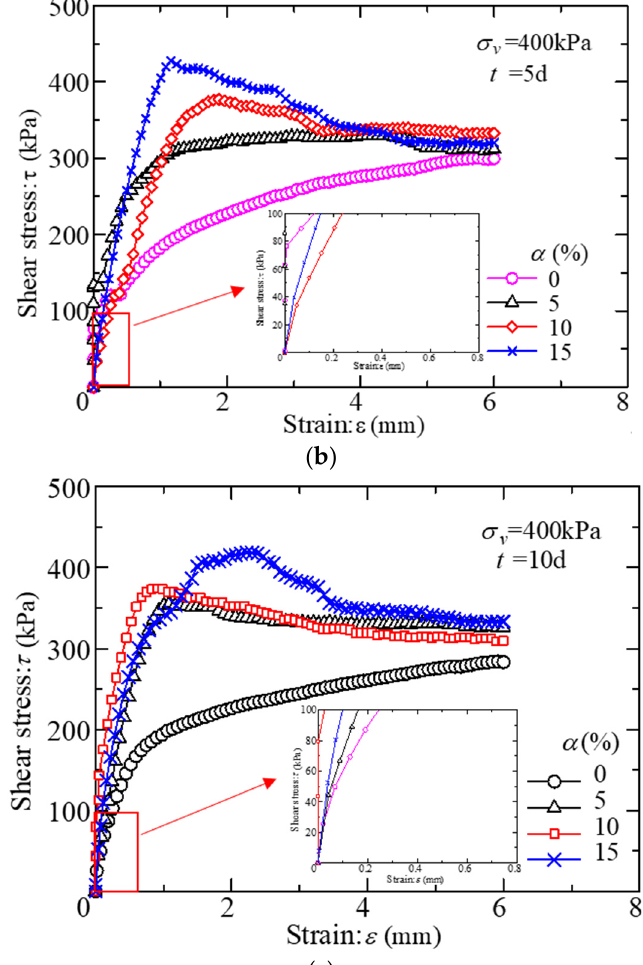
Figure 5. Effect of biochar content on a stress–strain curve of biochar–clay with bacteria. ( a ) σ v = 400 kPa, t = 0 d. ( b ) σ v = 400 kPa, t = 5 d. ( c ) σ v = 400 kPa, t = 10 d.